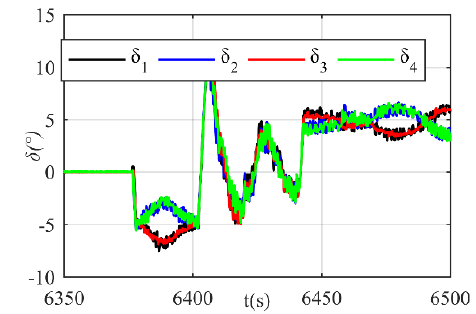
Figure 18. The actuator’s control inputs derived from normal command transformation.